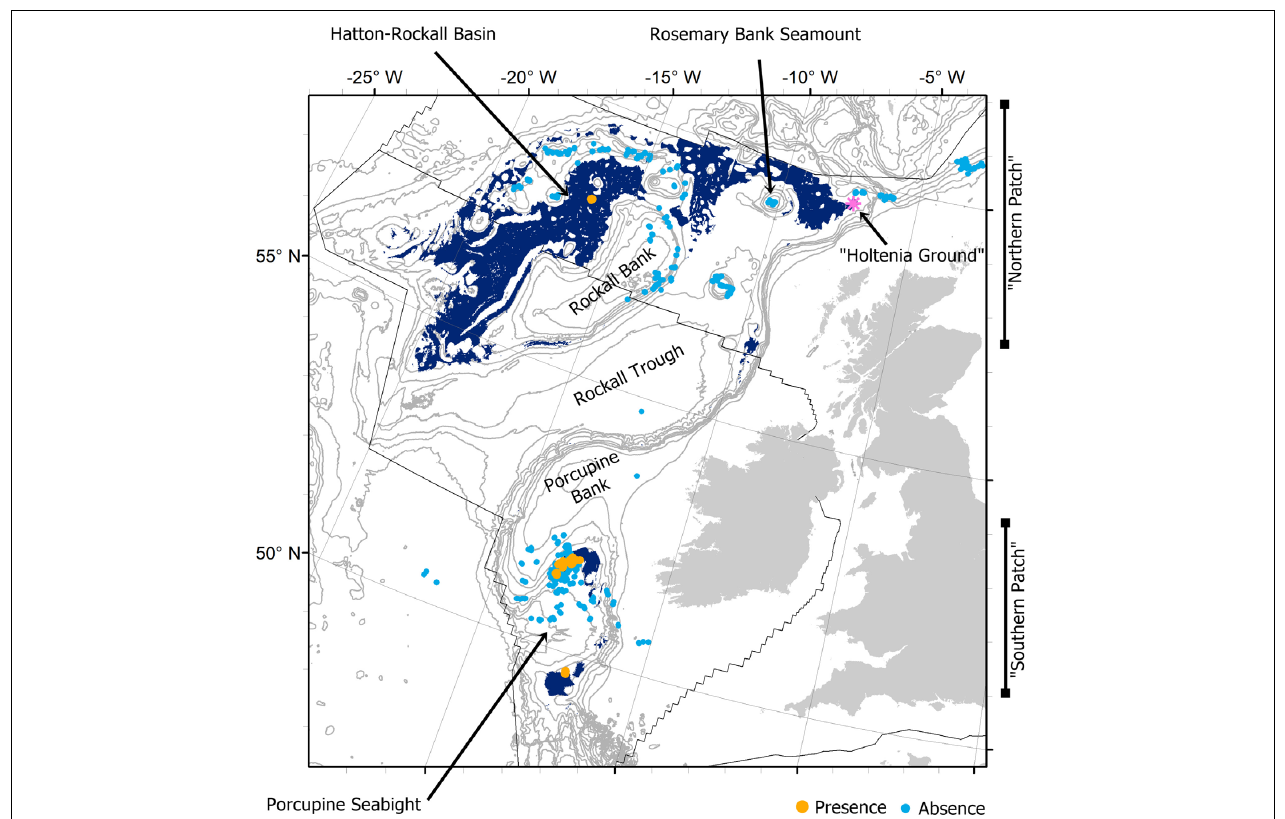
FIGURE 1 | A map of the study area showing the predicted distribution of Pheronema carpenteri aggregations in United Kingdom and Irish waters (after Ross and Howell, 2013). The prediction shows all areas where the likelihood of P. carpenteri aggregation presence is above 0.19 (a threshold selected to maximize the sensitivity and specificity metrics of assessment). Presence and absence data used to train the HSM (after Ross and Howell, 2013) are shown to contextualize known aggregations. Names of locations mentioned in the text are labeled. Background bathymetry contours from GEBCO show every 200–1000 m depth, then every 500 m. Black lines show the current extent of the United Kingdom and Irish continental shelves within the study